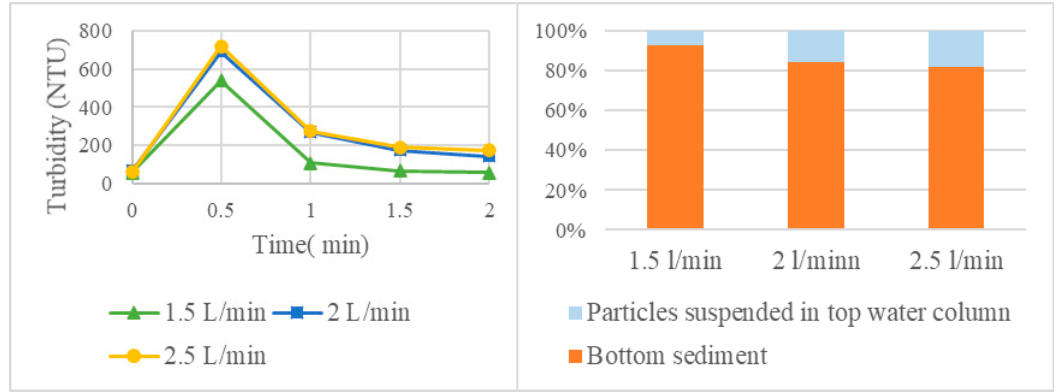
Figure 6. Turbidity variation and distribution of kaolin mass with inflow rate (J type inlet).